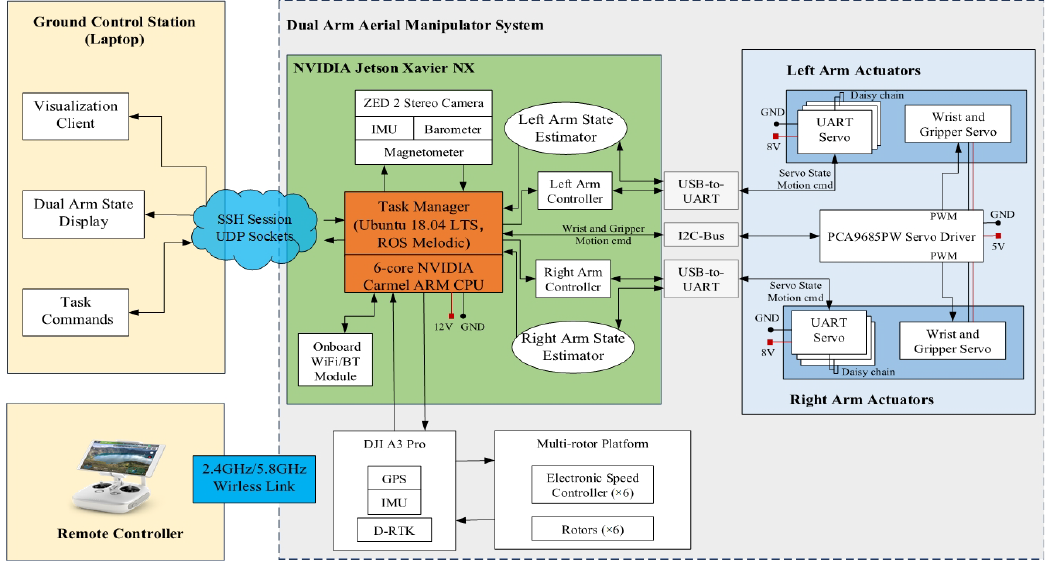
Figure 5. The hardware/software architecture of the dual-arm aerial manipulator system.